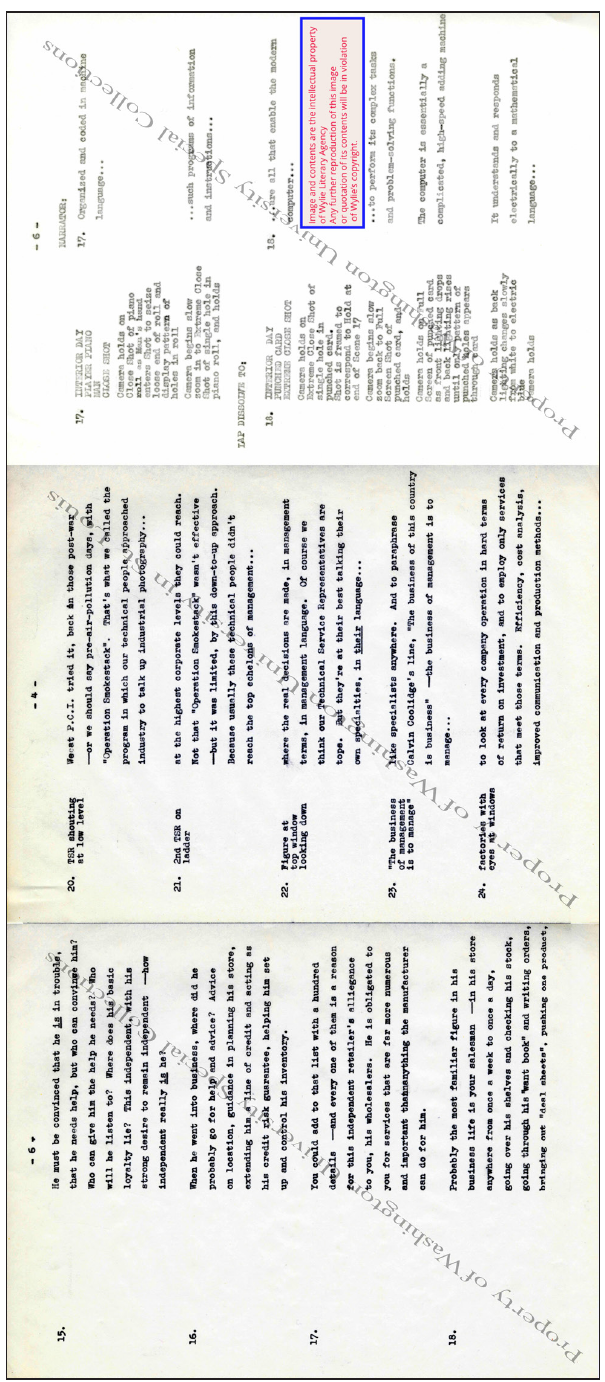
Figure 2: Three Slideshow Scripts,